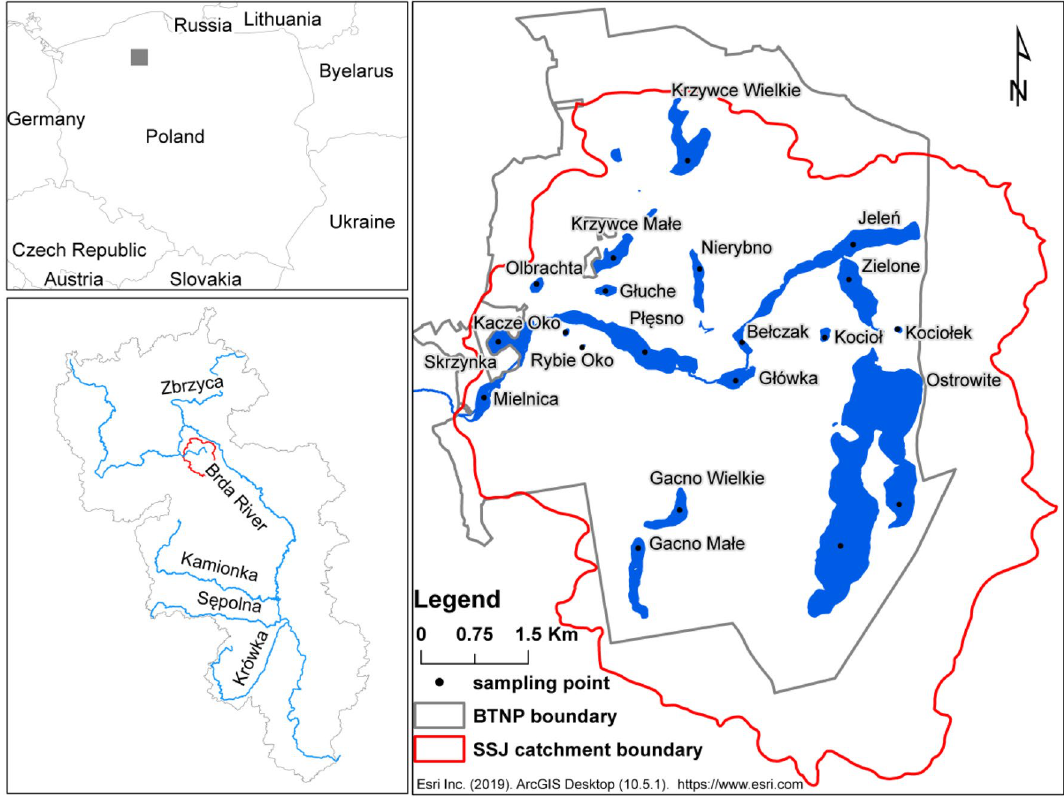
Figure 1. Study site location. Figure generated in ArcMap 10.5 (https ://deskt op.arcgi s.com/en/arcma